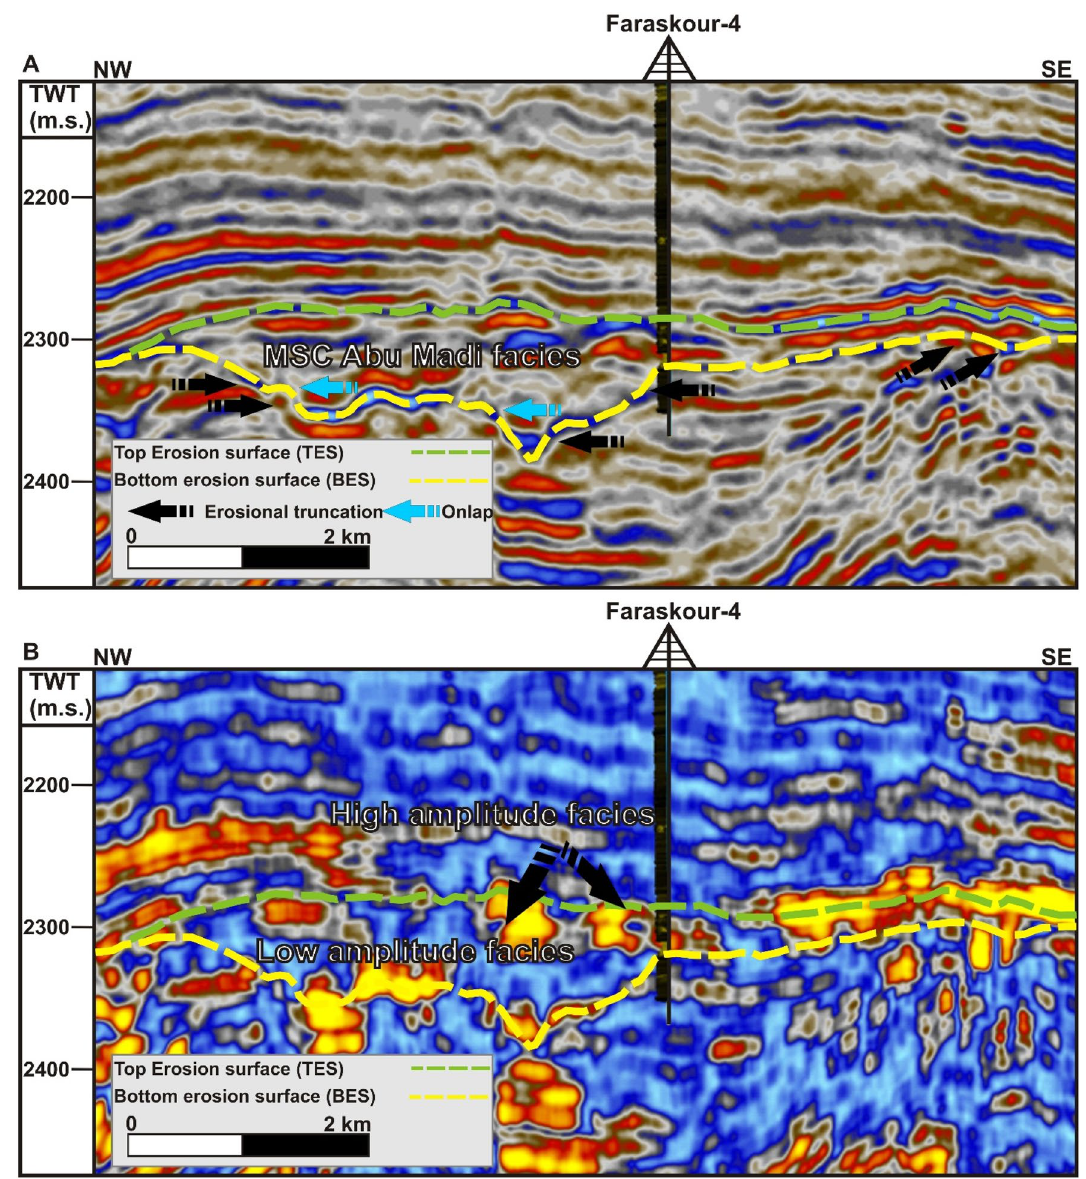
Fig. 6 Interpreted NW–SE seismic section in original amplitude ( a ) and RMS amplitude attribute ( b ) showing scattered high-amplitude bar fea- tures at the upper part of Abu Madi canyon-infill succession (see location in Fig.